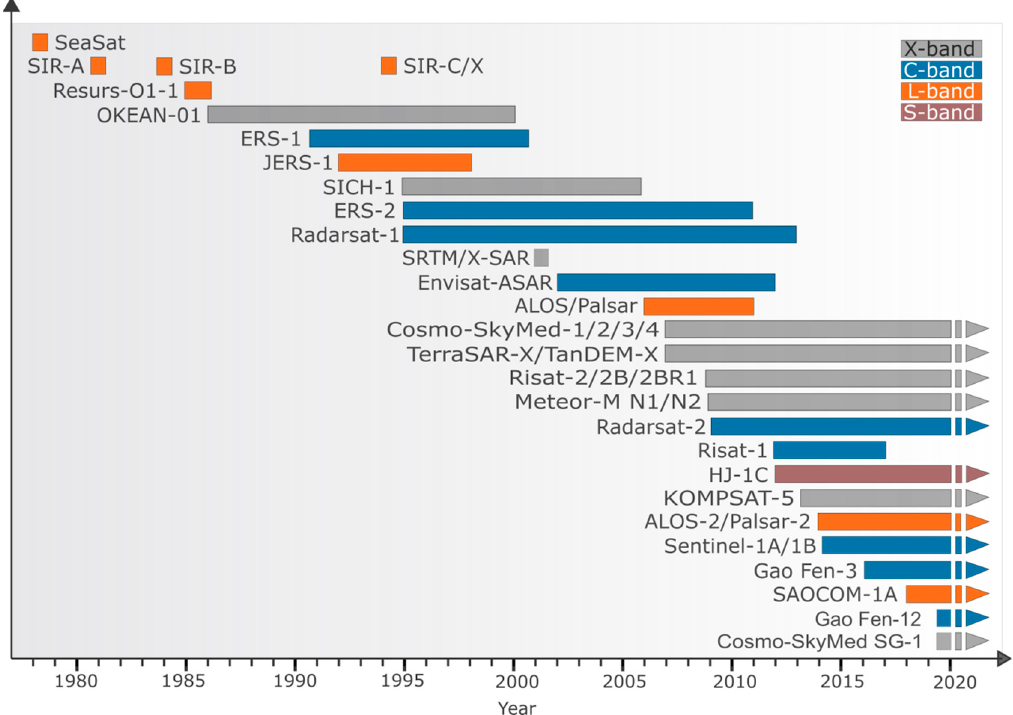
Figure 6. Timeline of inactive and active spaceborne SAR instruments with different wavelengths (X-, C-, L- and S-band).